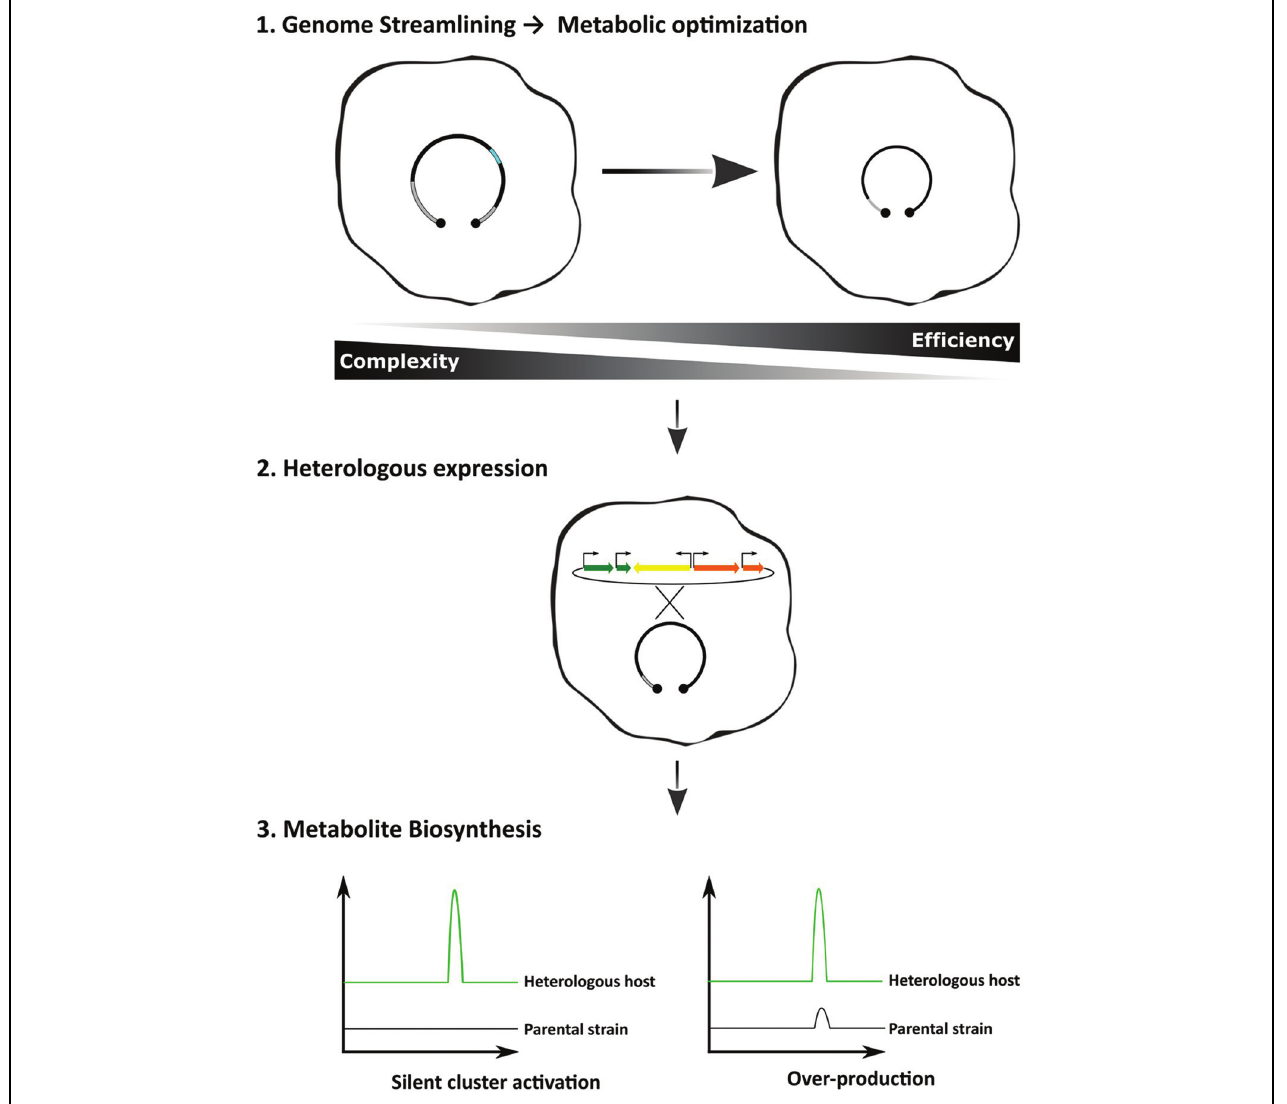
FIGURE 1 | Optimized workflow for the heterologous expression of biosynthetic gene clusters. Applying the concept of genome simplification, one should expect that the host-interference problem would be minimized rendering more efficient strains. The methods of gene delivery and cluster refactoring can